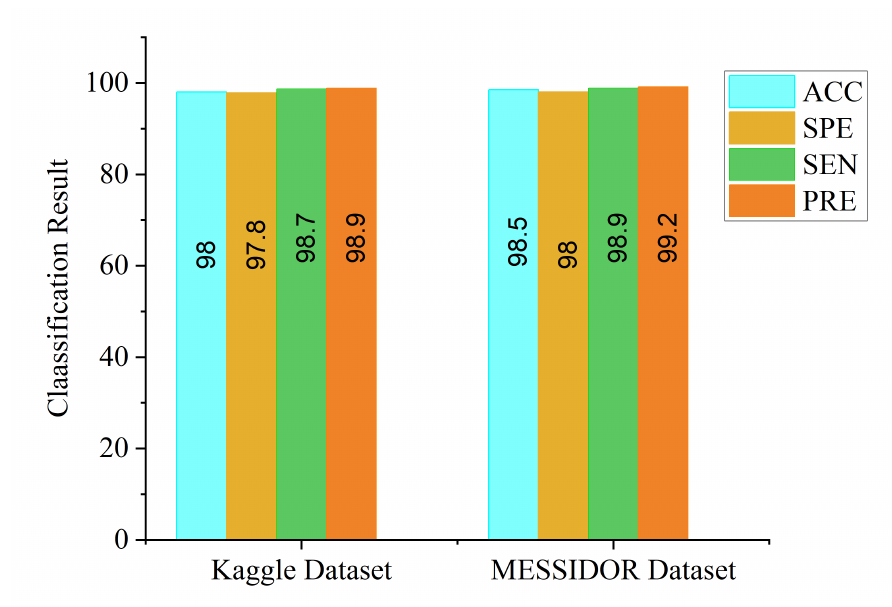
Figure 10. Classification result of our proposed model on Kaggle and Messidor datasets.